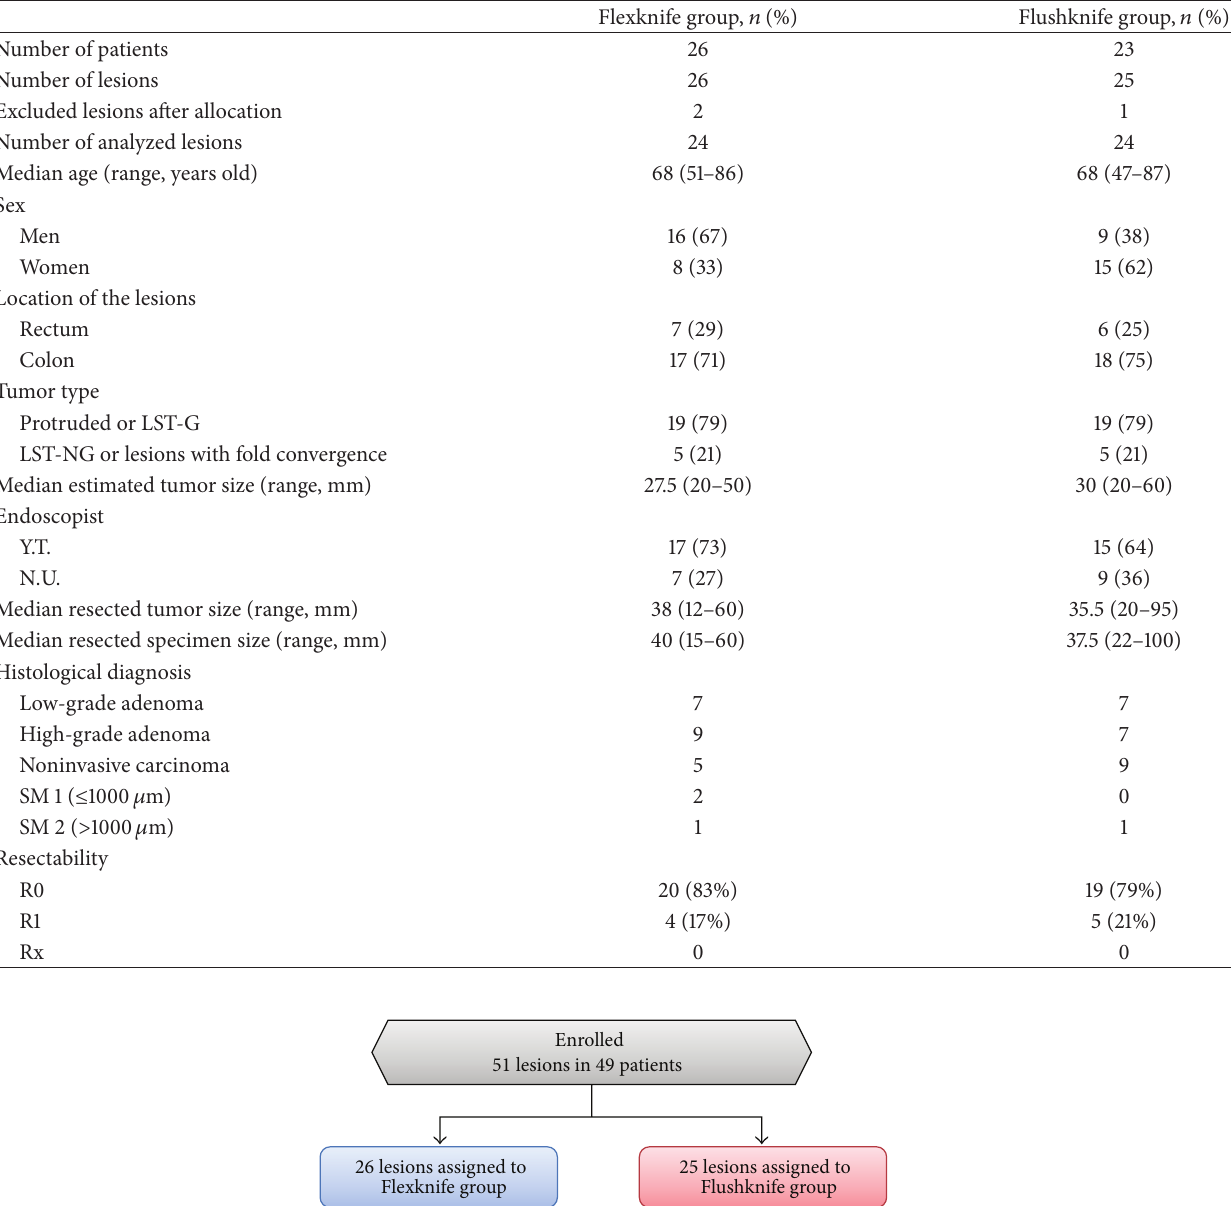
Table 1: Baseline and clinicopathological features of the treatment groups.